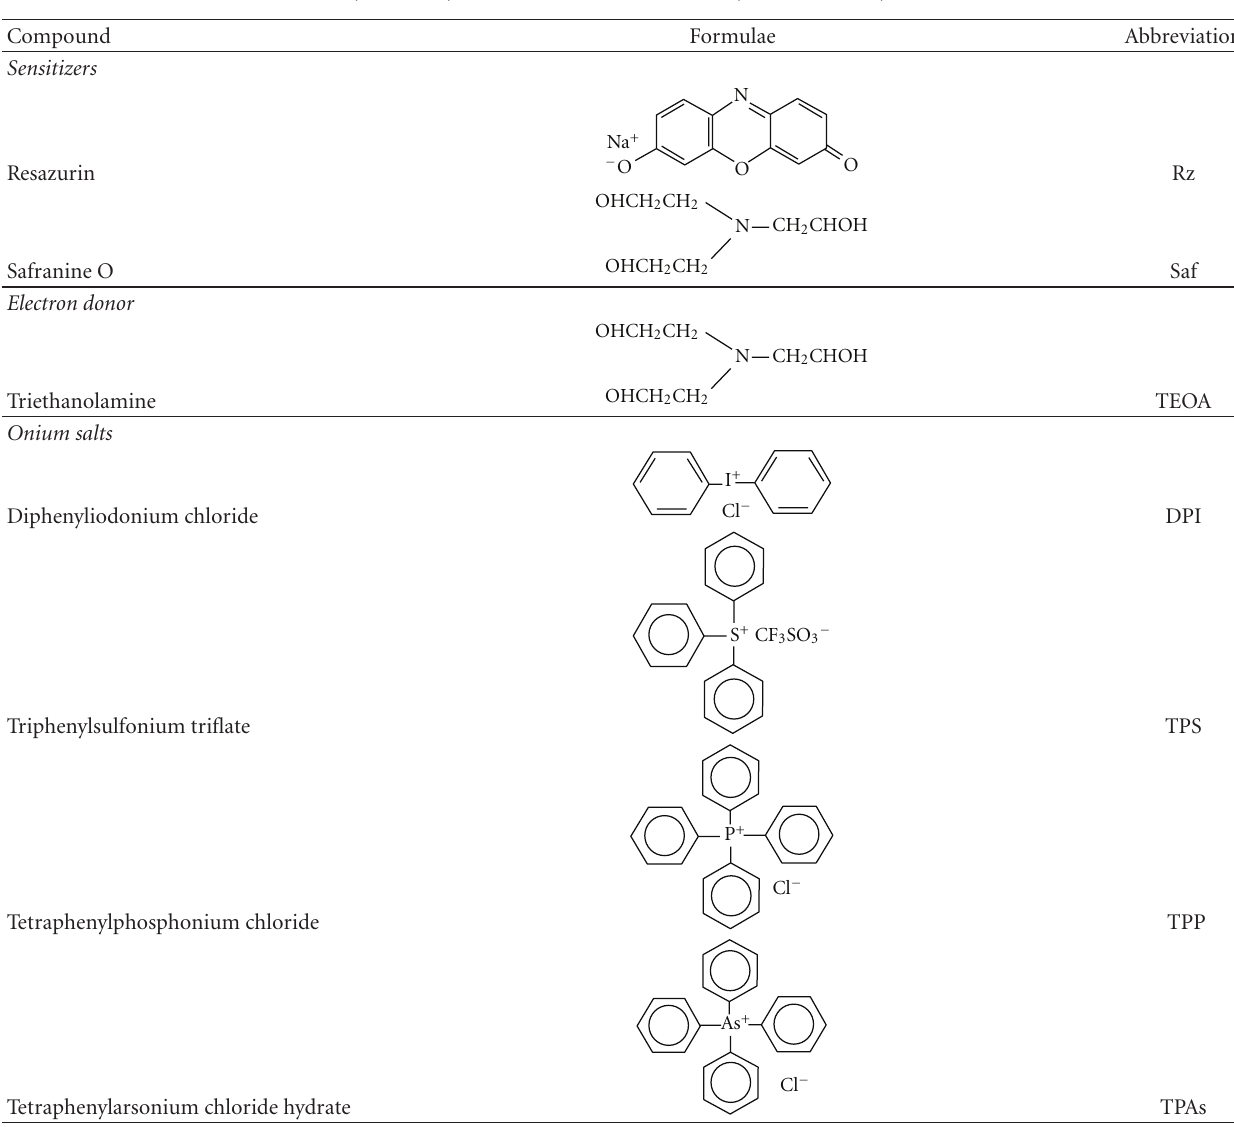
Table 1: Names, formulae, and abbreviations of sensitizers, electron donor, and onium